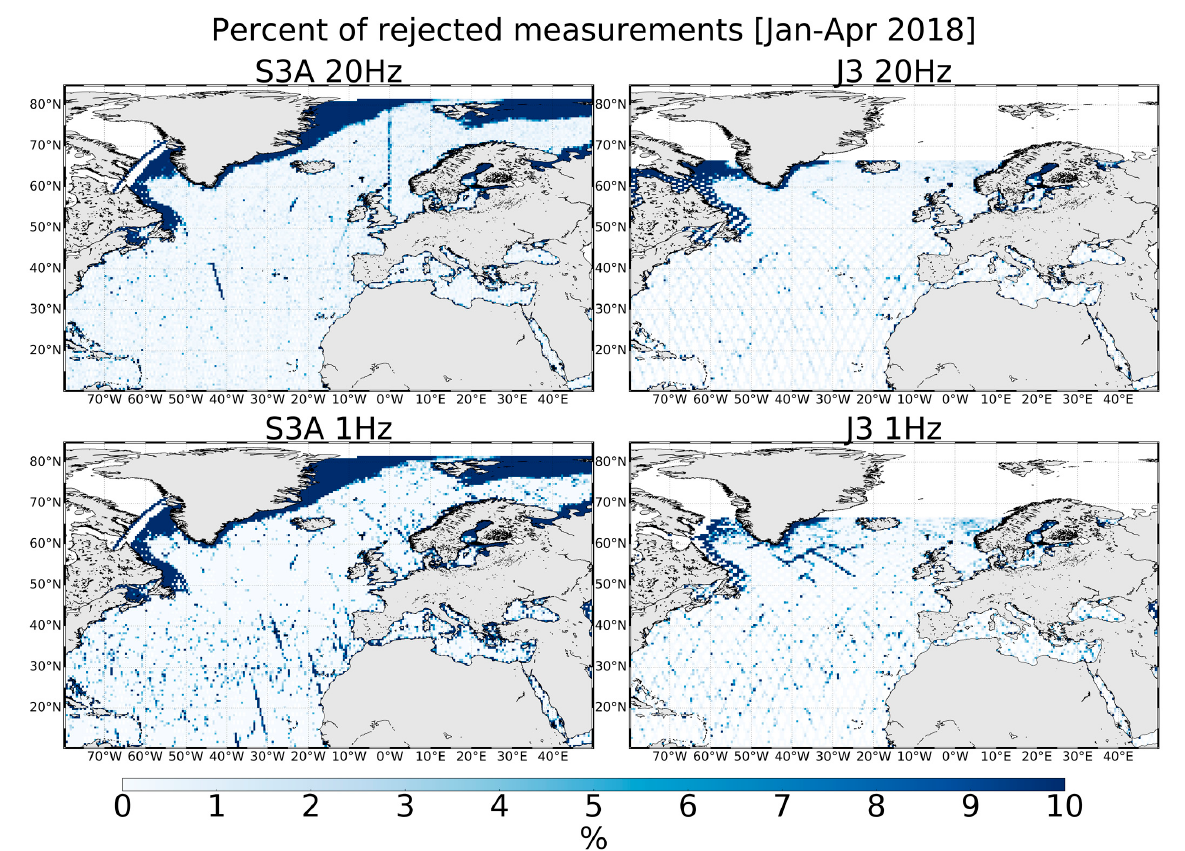
Figure 4. Percentage of rejected measurements for S3A ( left ) and J3 ( right ) missions for January–April 2018. Results obtained for 20 Hz ( top ) and 1 Hz ( bottom ) measurements selected with the respective editing strategy.